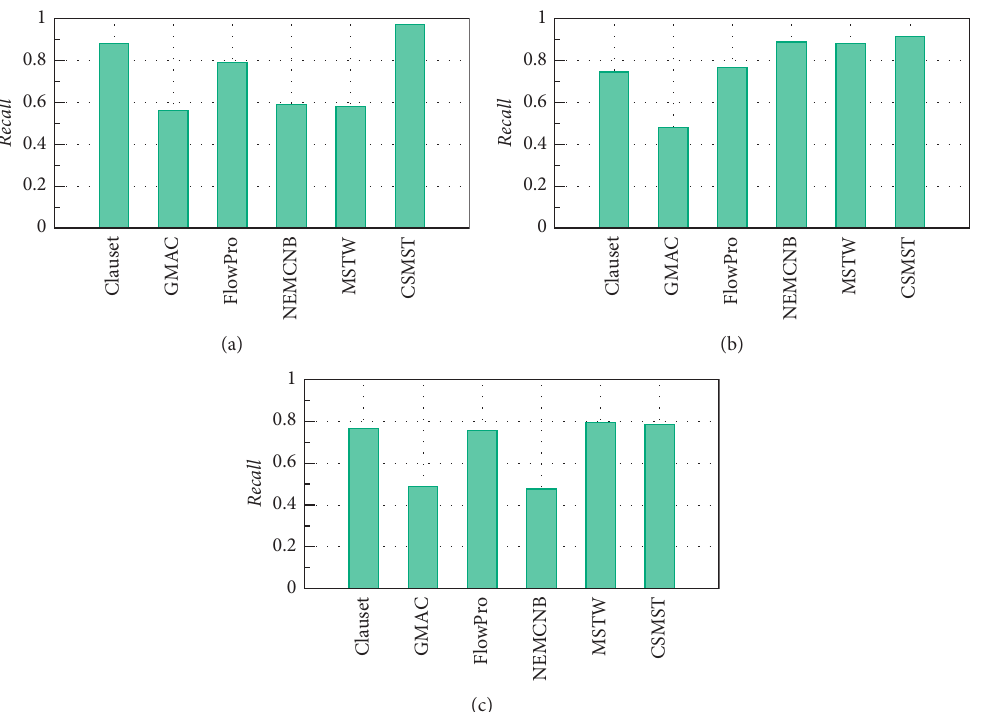
Figure 6: Comparison results on real-world networks with community search baselines. (a) Comparison result on Karate. (b) Comparison result on Football. (c) Comparison result on